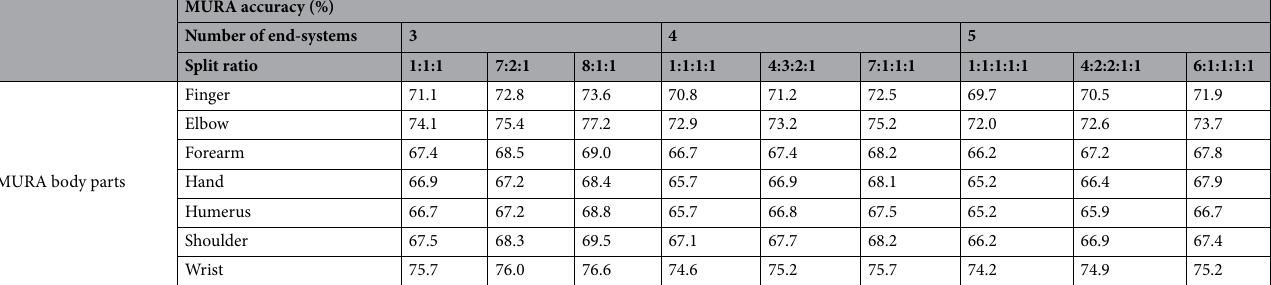
Table 3. Classification accuracy using MURA body parts.